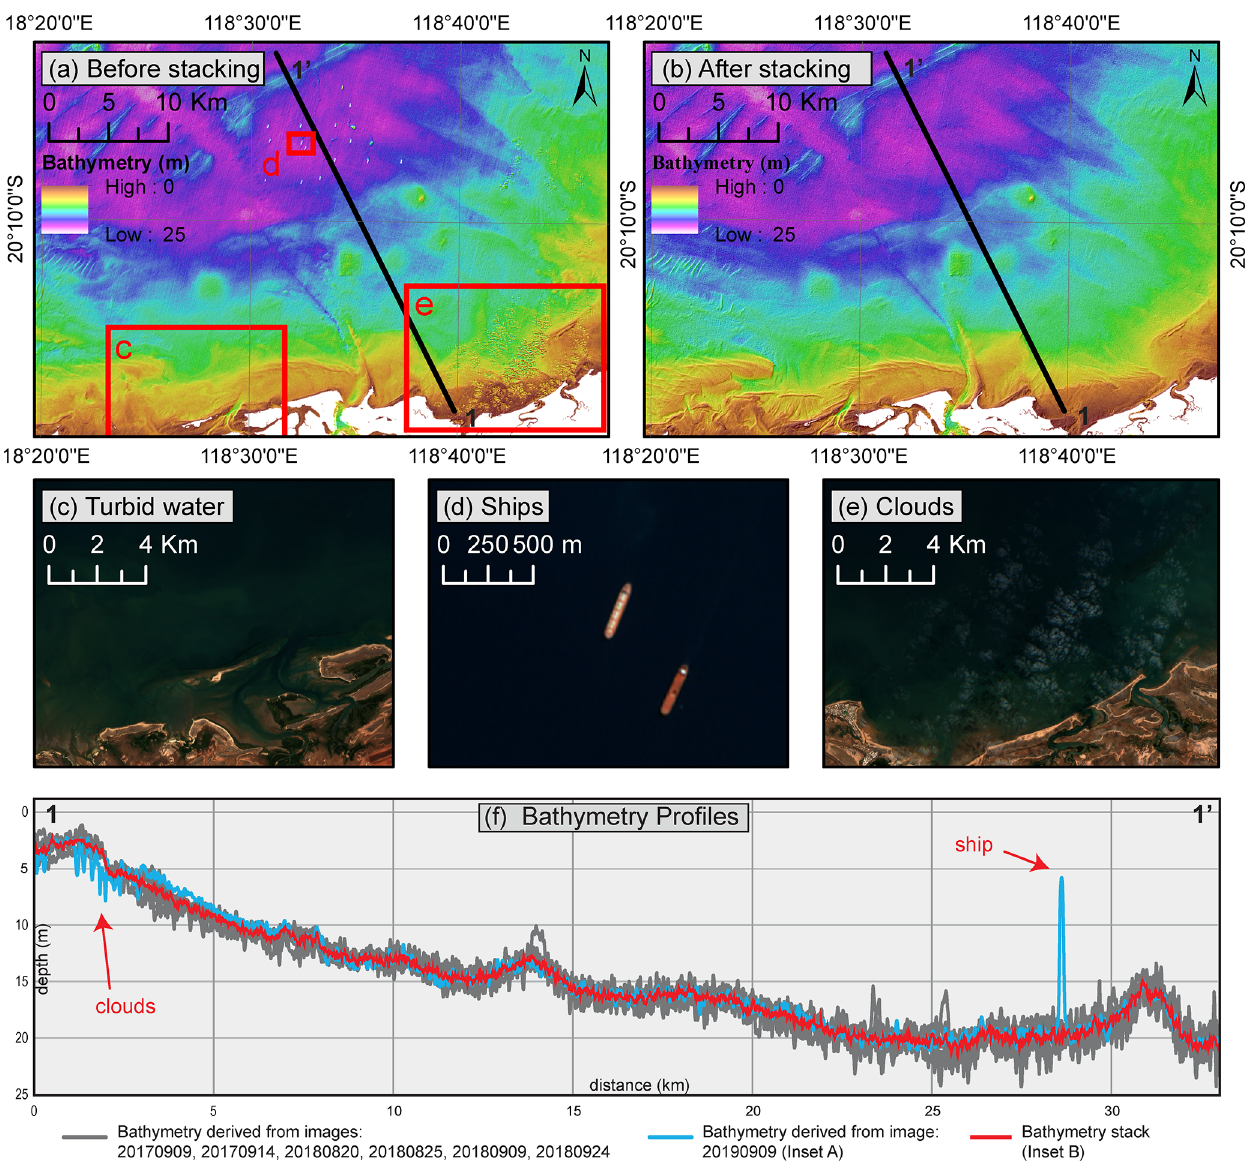
Figure 9. Illustration of the stacking process near Port Hedland (tile “KPC”). In the area, seven images met the specified coefficient-of- correlation threshold and were kept for the stacking. Each satellite image is affected by temporal effects that can be seen from red–blue– green (RGB) displays (see example c , d , e ; Sentinel-2 L2a RGB image 20190909 was accessed through Sentinel Playground, the visualization portal of Sinergise Ltd) and on the resulting derived bathymetry (see panel a and cross section f , blue profile, derived from Sentinel-2 L2a image 20190909). The median value of all images was then calculated resulting in the removal of temporal artefacts ( b , cross section f , red profile). For data sources, see Sect.